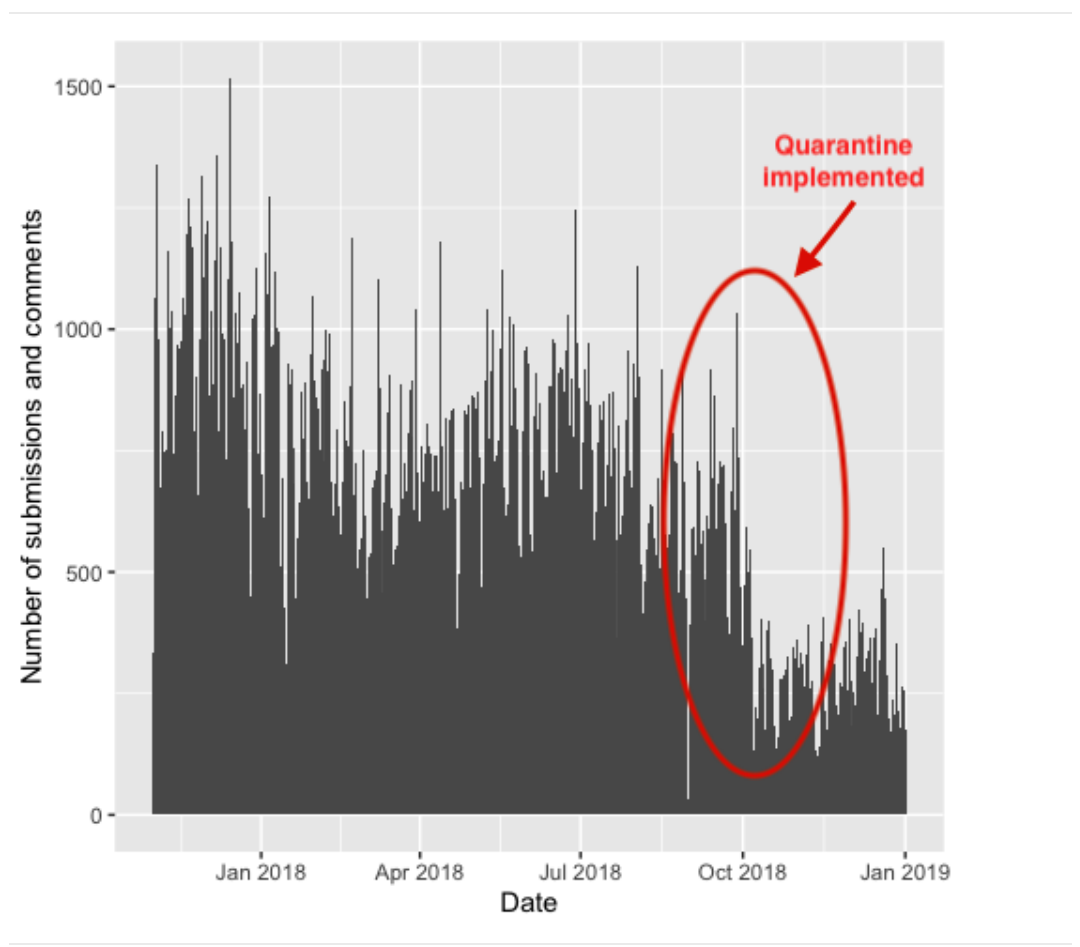
FIGURE 2 : The Red Pill submissions and comments frequency